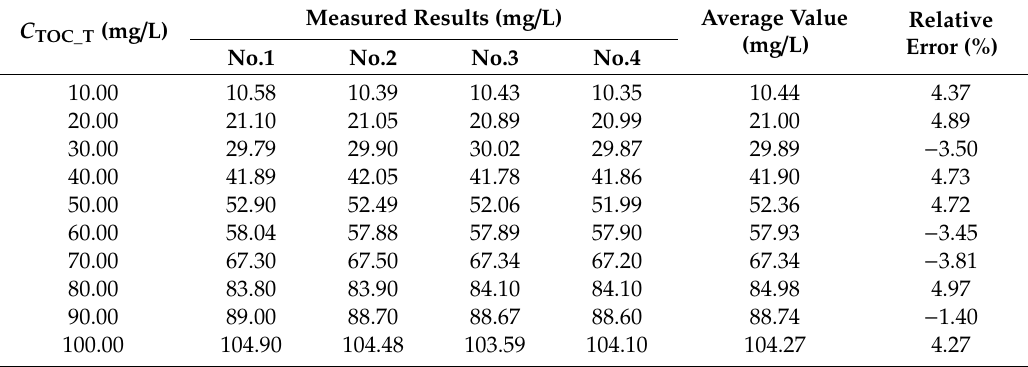
Table 6. Measured results and relative errors for di ff erent concentrations of TOC solution.